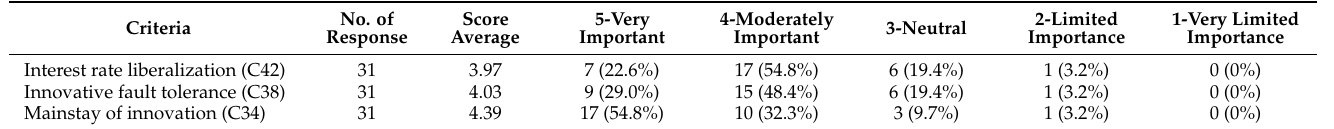
Table 5. Results of the second-round survey of modified Delphi method.